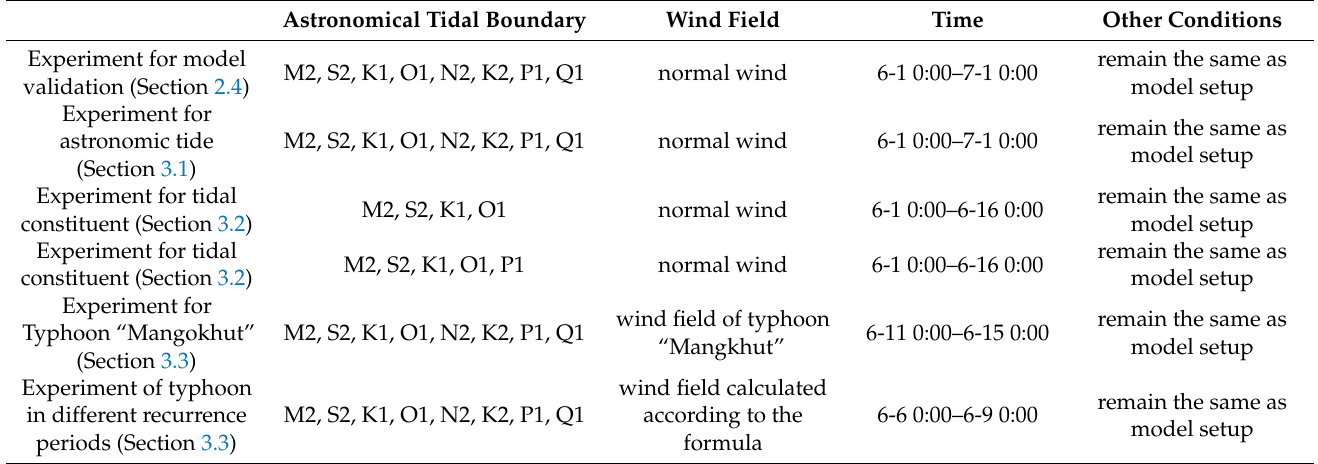
Table 1. Parameter setting of each